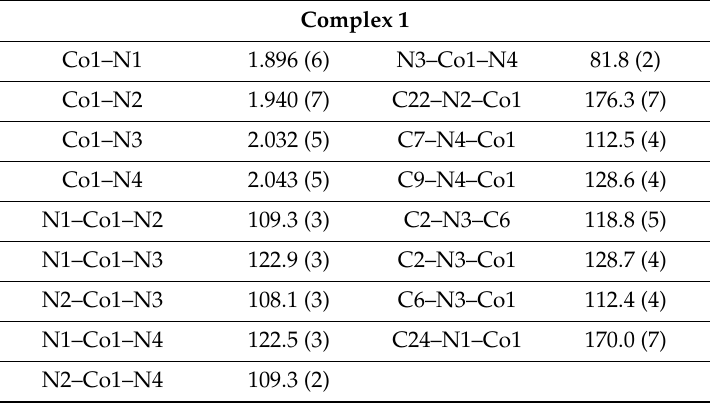
Table 2. Selected bond distances (Å) and angles (deg) for complex 1